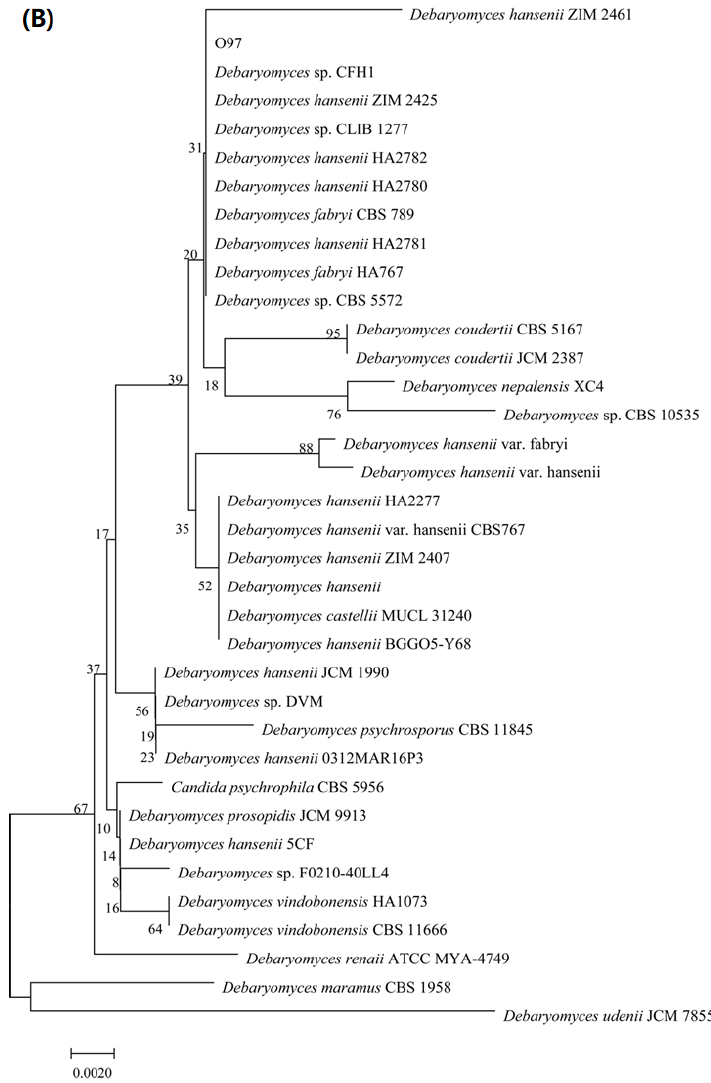
Figure 2. Identification of limonene resistant microorganisms. ( A ) Phylogenetic tree of strain O852 based on the 16S rDNA gene sequence. ( B ) Phylogenetic tree of strain O97 based on the ITS gene sequence. Table 1. Concentration (mg/L) of limonene biotransformation products obtained at different periods (24 h, 48 h, 72 h).